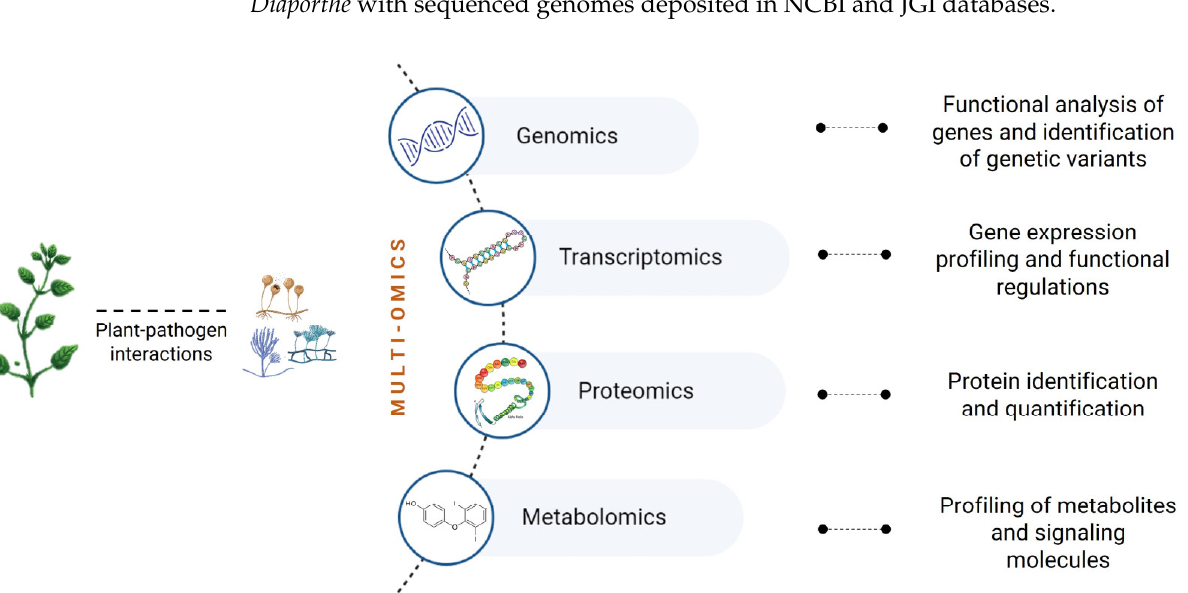
Table 2. Synopsis of all Diaporthe strains with genomes sequenced. (Note: NA stands for ‘not appli- cable’ meaning that the genome is available at the JGI Portal but has no Project